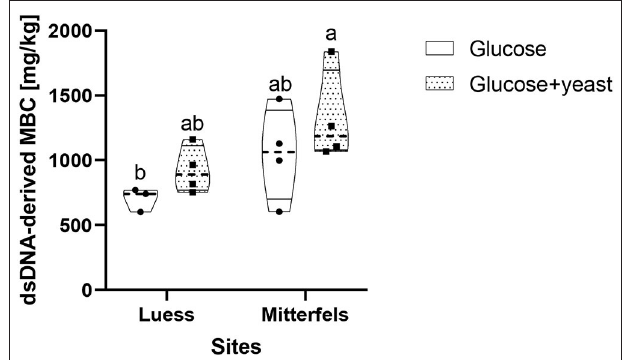
FIGURE 9 | Violin plot of dsDNA-derived microbial biomass C (MBC) content during the first 10h after substrate addition for nutrient-poor soil (Luess) and nutrient-rich soil (Mitterfels). The dashed line shows the median of MBC, the dots denote the replicates and the thin black line the quartiles. The lower-capital letter depicts the significant differences between sites at a level of